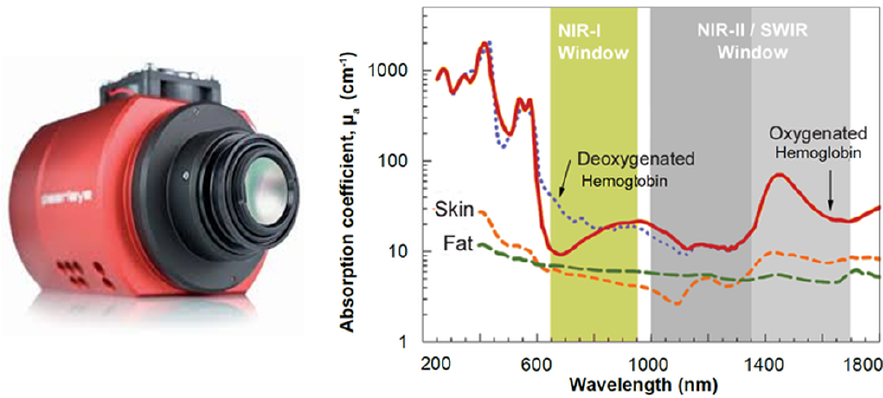
Figure 7. ( Left ) example of an SWIR camera used in research and medical applications (courtesy of Stemmer Imaging Inc, Zutphen, The Netherlands); ( Right ) absorption chart of light in tissue (courtesy of Dr. Dominik J. Naczynski, Stanford University, Stanford, CA, USA, adapted from